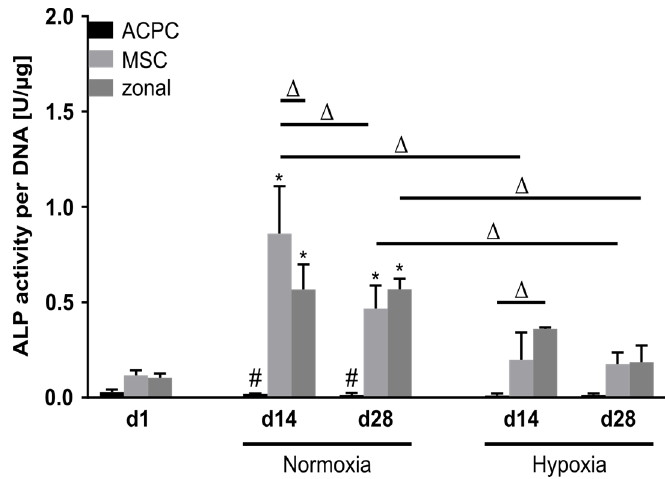
Figure 6. Alkaline phosphatase activity in ACPC, MSC, and zonal constructs. ALP activity in agarose hydrogel constructs, seeded with 20.0 × 10 6 cells mL − 1 , after 1, 14, and 28 days of chondrogenic differentiation under normoxic and hypoxic conditions. ACPCs and MSCs were either cultured alone or in zonally layered co-culture constructs. Data are presented as means ± standard deviations ( n = 3 biological replicates). Note: (*) indicates statistically significant differences between a d14 or d28 value and the corresponding d1 value of the same group ( p < 0.05); (#) indicates statistically significant differences of this group compared to the other two groups that share the same time point and oxygen condition ( p < 0.05); ( Δ ) indicates statistically significant differences between groups, or within a group between time points ( p < 0.05).